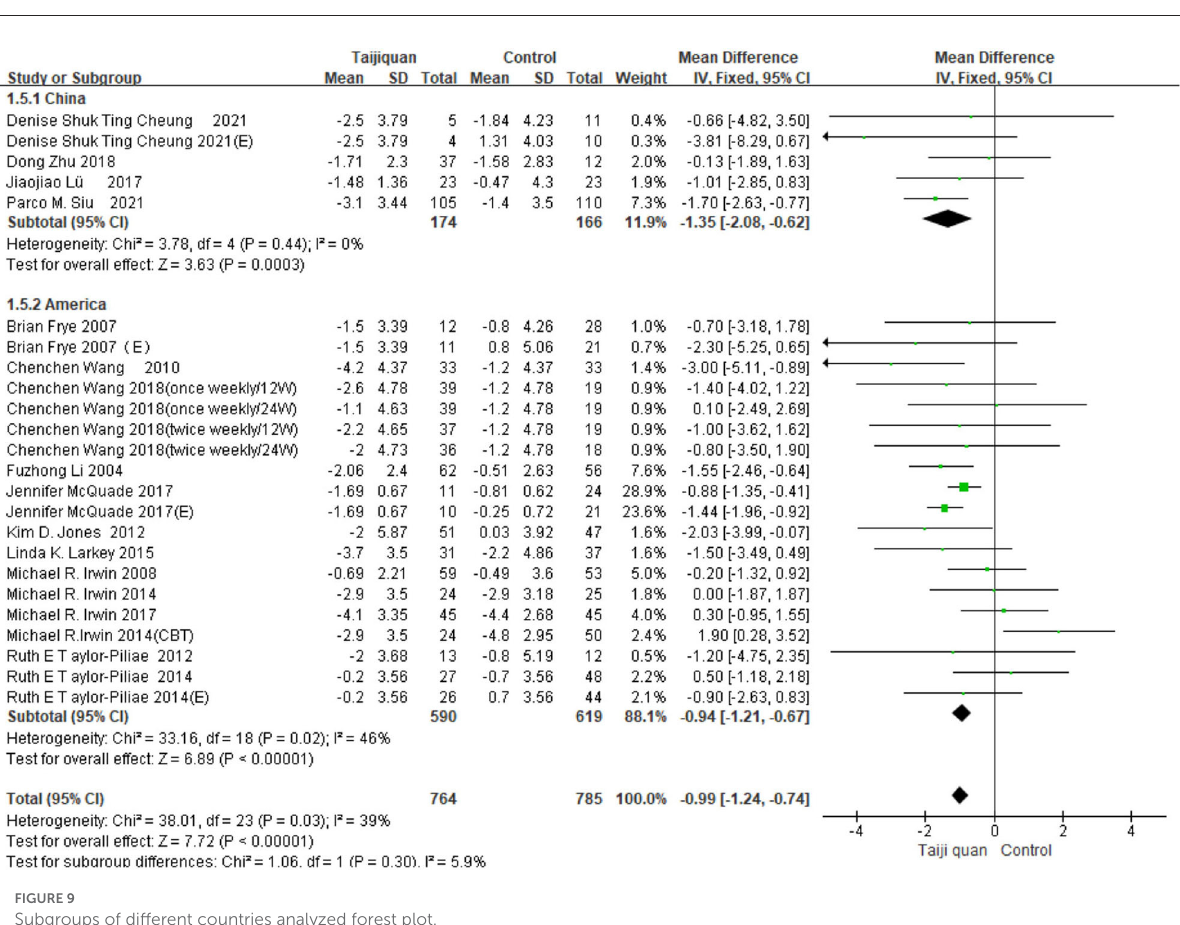
of pro-inflammatory cytokines to prevent insomnia (46,